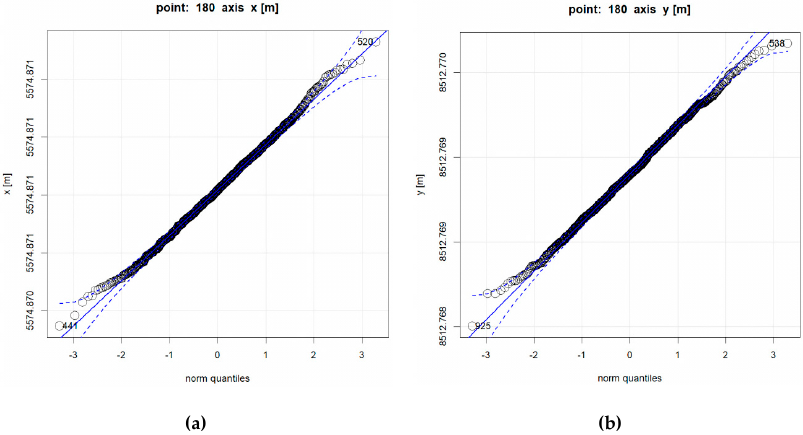
Figure 10. Q–Q plots for comparing probability distributions of ( a ) x- and ( b ) y-coordinates of station 180: If real values lie within dashed line, here assumed normal distribution is accepted.